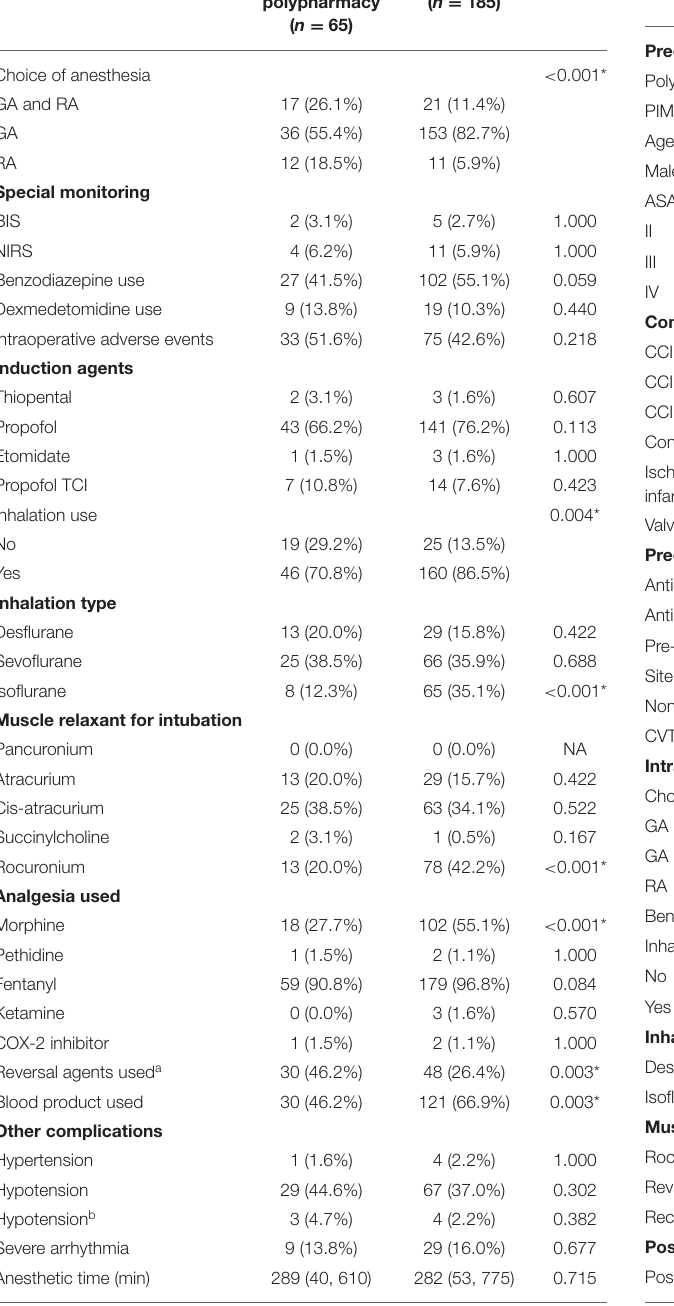
TABLE 4 | Variables potentially associated with postoperative cognitive dysfunction (POCD) compared between the non-POCD and POCD